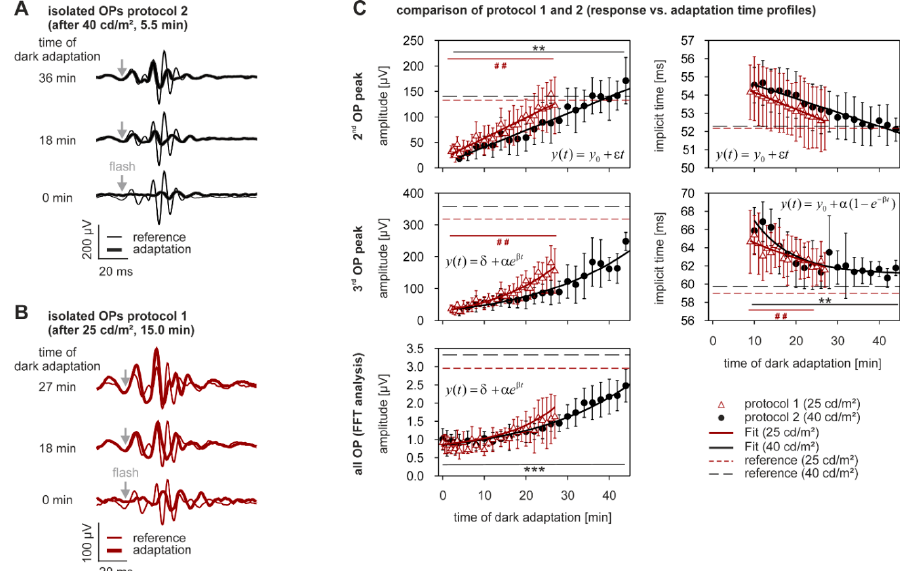
Figure 4. Dark adaptation—oscillatory potentials. ( A , B ) OPs, shown in the same format as Figure 6. (C) OP amplitudes and implicit times vs. time of dark adaptation (same format as in Figure 6). n after 40 cd/m2 = 9, n after 25 cd/m2 = 5.